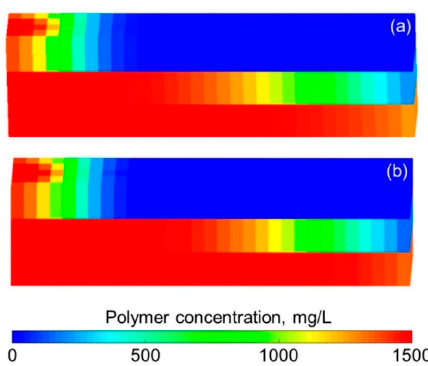
Figure 10. Comparison of 3D polymer concentration distributions after cumulative injection volume of 1.67 PV of ( a ) ECLIPSE V2013.1 software and ( b ) designed simulator in running the case without polymer degradation.